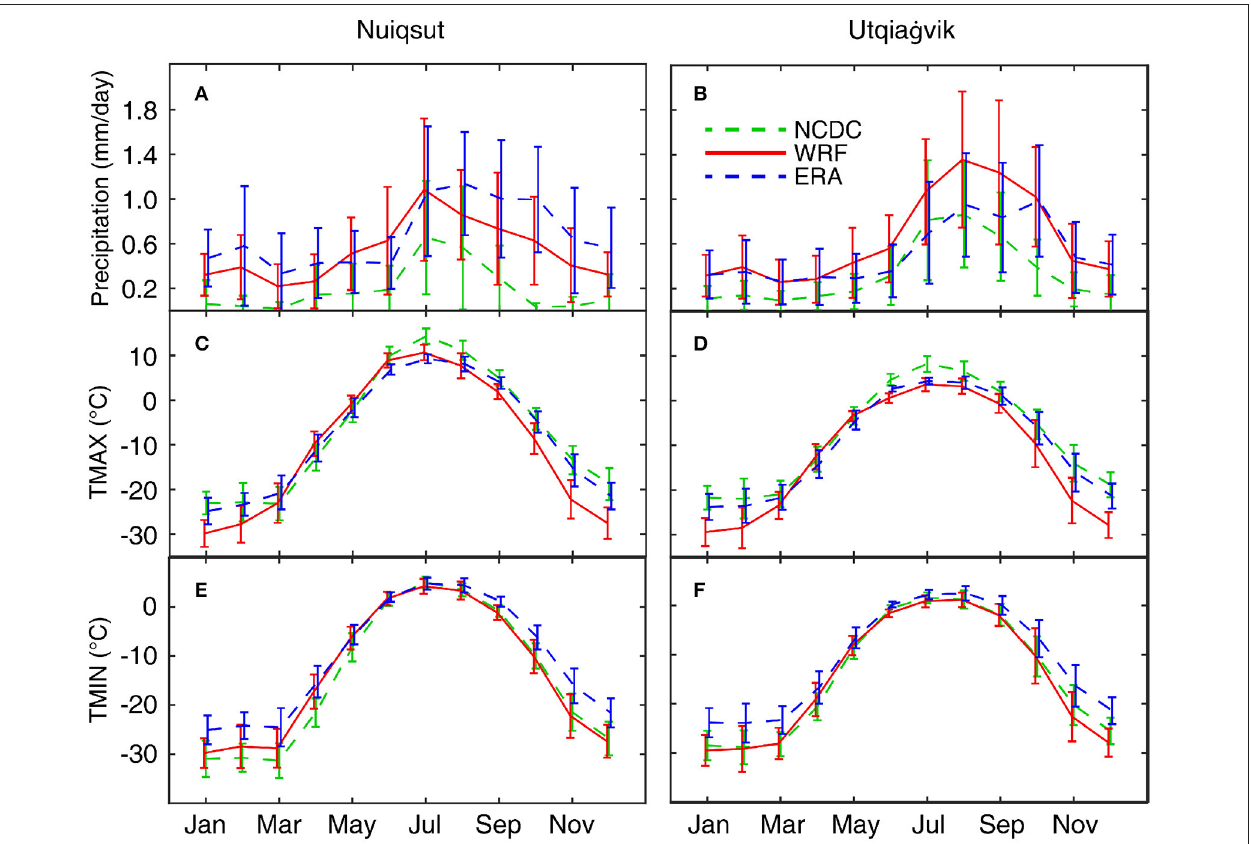
FIGURE 4 | Monthly climatology comparisons between the NCDC GHCN-D observations (green dashed lines), downscaled ERA-WRF output (red solid lines), and ERA-interim reanalysis data (blue dashed lines) of average precipitation (mm/day), maximum and minimum air temperature (TMAX and TMIN, ◦ C) for each month at the coastal towns of Nuiqsut (A,C,E) and Barrow (B,D,F) . Average annual precipitation for these two stations is larger in the ERA-interim (215.4mm) and the downscaled ERA-WRF (212.5mm) than conventional observations